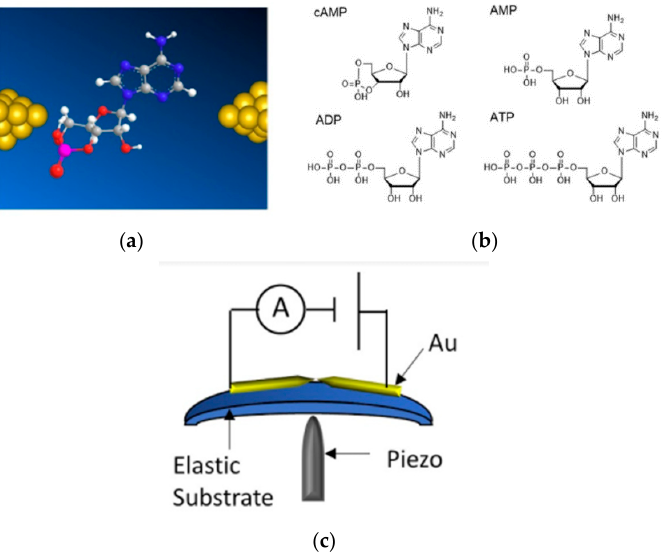
Figure 1. ( a ) Schematic image of single-molecule measurement of nucleotide-type second messenger, e.g., cyclic adenosine monophosphate (cAMP), using nanogap electrodes. ( b ) Chemical structures of four targeted molecules: cyclic adenosine monophosphate (cAMP), adenosine triphosphate (ATP), adenosine monophosphate (AMP), and adenosine diphosphate (ADP). ( c ) Device and measurement system. The mechanically controllable break-junction (MCBJ) system was used for the formation of nanogap